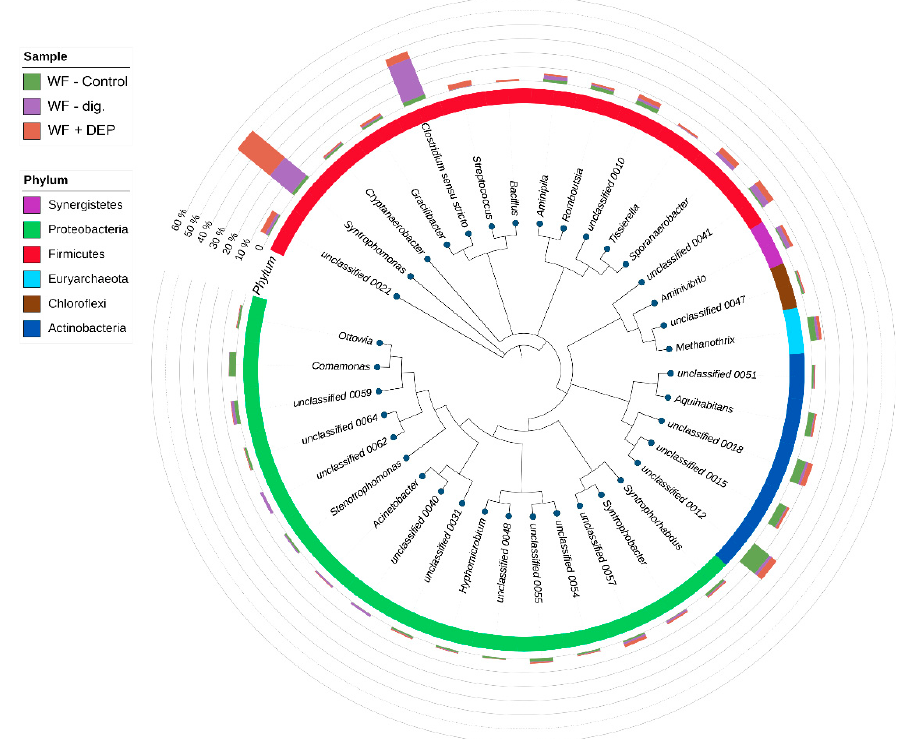
Figure 4. The phylogenetic tree representing the most abundant taxa (at the genus level). Outer bars visualise each taxa abundance in the corresponding sample. Inner bars visualise phylum affiliation of each genus.